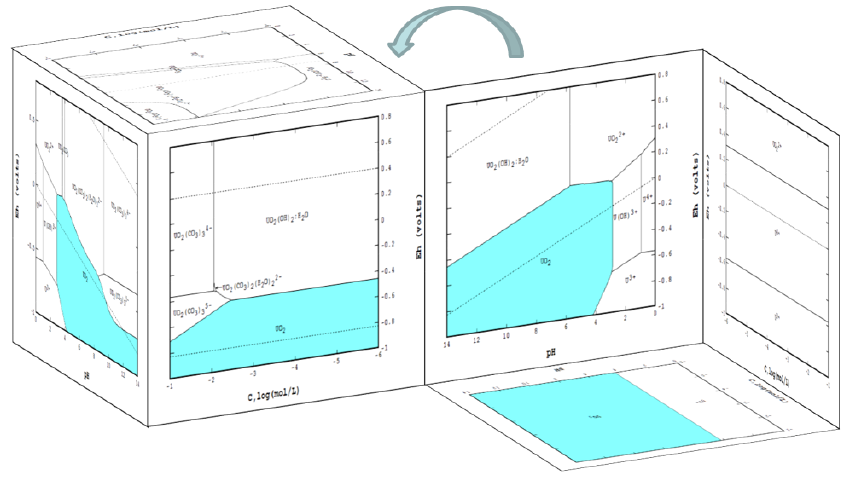
Figure 33. Combination of six surface plots of the U Eh-pH-log CO 2 system to form a cube.